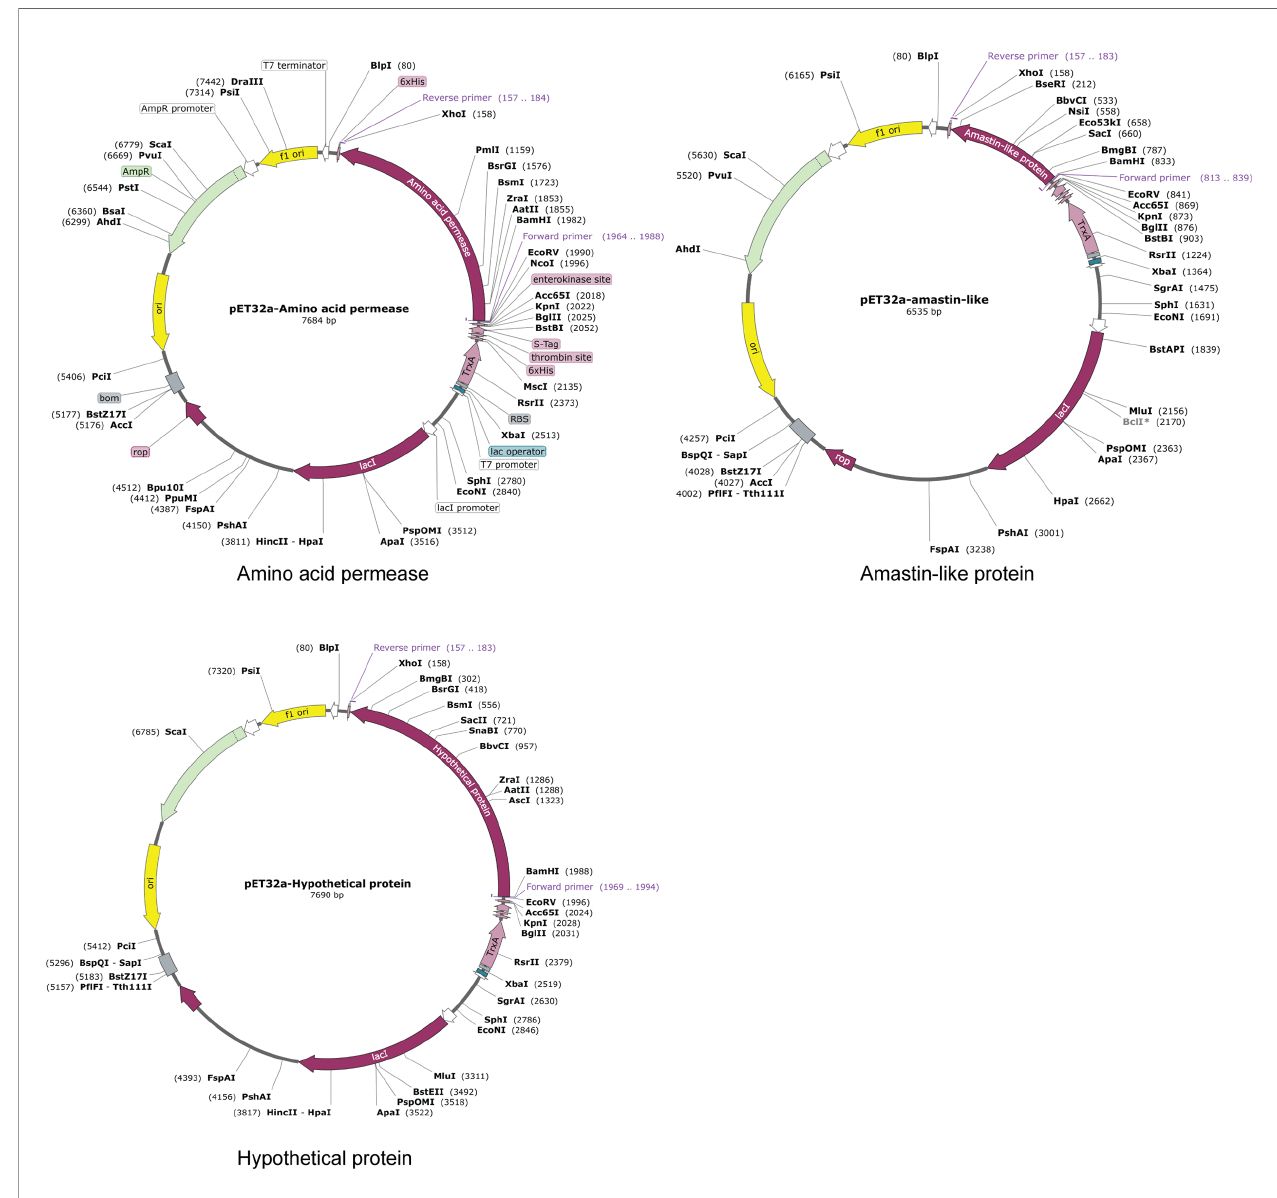
FIGURE 8 | In silico cloning. The coding sequences of amino acid permease, amastin-like protein, and the hypothetical protein (XP_003865405.1) were cloned into the pET32a (+) expression vector and represented in the red region. The inserts were added with XhoI and BamH I restriction